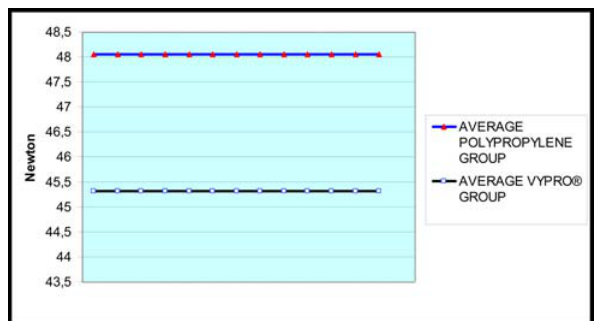
FIGURE 10 - Average values of tensile strength for polypropylene and vypro® groups.